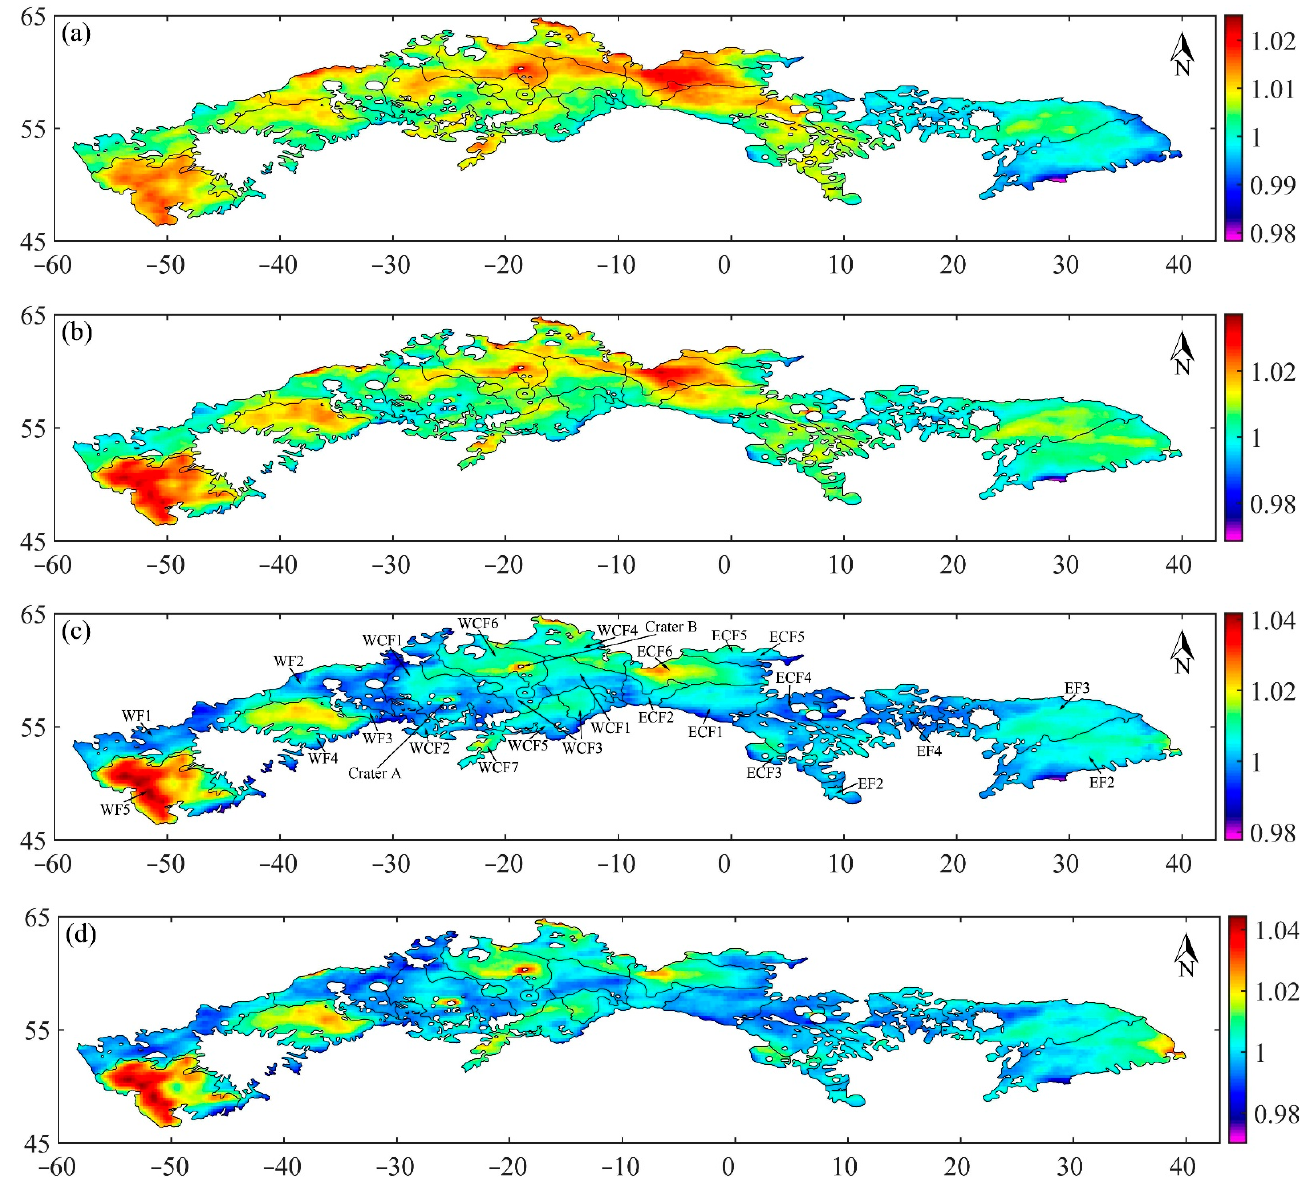
Figure 4. Normalized TB maps of Mare Frigoris at noon: ( a ) 3.0 GHz, ( b ) 7.8 GHz, ( c ) 19.35 GHz, and ( d ) 37 GHz (equidistant cylindrical projection). The black lines are the geologic boundaries of Mare Frigoris mapped by Kramer et al. [2]. Crater A and Crater B are two craters with TB anomalies, as discussed in Sections 3.2.2 and 4.2.1.